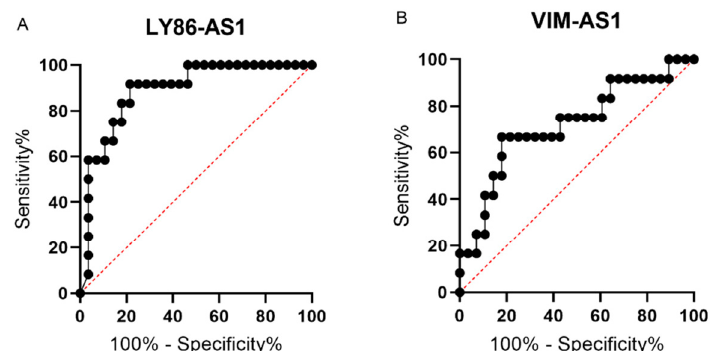
Figure 3. Receiver operating characteristic (ROC) curves for lncRNAs LY86-AS1 ( A ) and VIM-AS1 ( B ) that were found to be significantly deregulated in bone marrow plasma cells (BMPCs) of multiple myeloma (MM) and plasma cell leukemia (PCL) patients in the validation phase of the study.